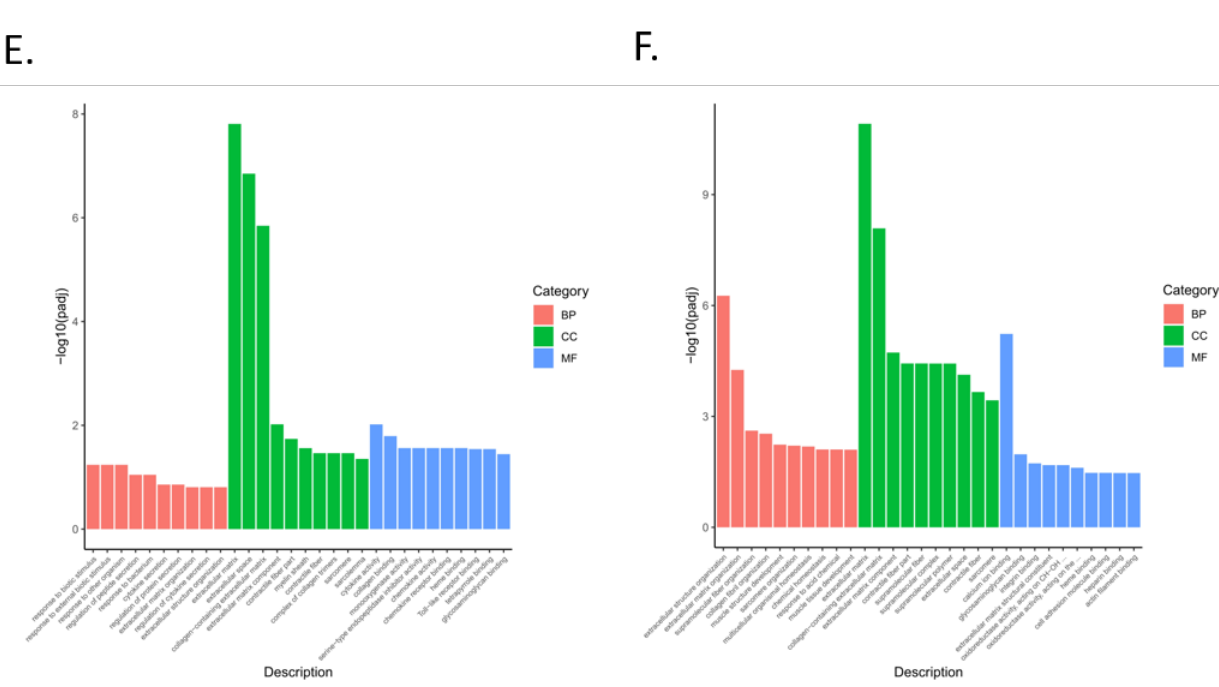
Figure 4. GO enrichment analysis of DEGs in different comparison groups. S_Z vs. S_B ( A ), K_Z vs. K_B ( B ), H_Z vs. H_B ( C ), M_Z vs. M_B ( D ), J_Z vs. J_B ( E ), and Z_Z vs. Z_B ( F ). GO terms are on the x -axis. The enrichment ratio of genes is shown as GO terms for BP, CC, and MF. S_Z: the duodenum of healthy rabbits, S_B: diarrhea in the duodenum of rabbits, H_Z: healthy rabbit ileum, H_B: rabbit with diarrheal ileum, K_Z: healthy rabbit jejunum, K_B: rabbits with diarrheal jejunum, M_Z: healthy cecum of rabbits, M_B: rabbits with diarrheal cecum, J_Z: healthy rabbit colon, J_B: colon of rabbits with diarrhea, Z_Z: healthy rabbit rectum, Z_B: rectum of rabbits with